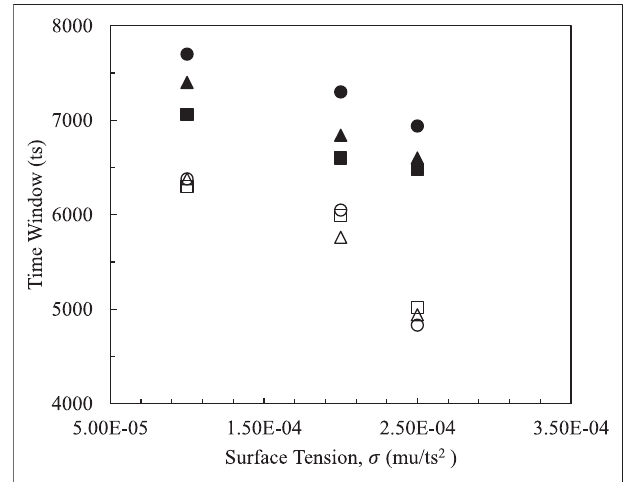
FIGURE3| Effects ofdropletssizesontimewindows: circles( R (cid:1) 35lu), squares ( R (cid:1) 25 lu) and triangles ( R (cid:1) 15 lu) represent three speci fi ed droplet sizes,respectively;emptysymbolsstandforthicksurfaces( d (cid:1) 10lu)andsolid symbols mean thin surfaces ( d (cid:1) 5 lu),